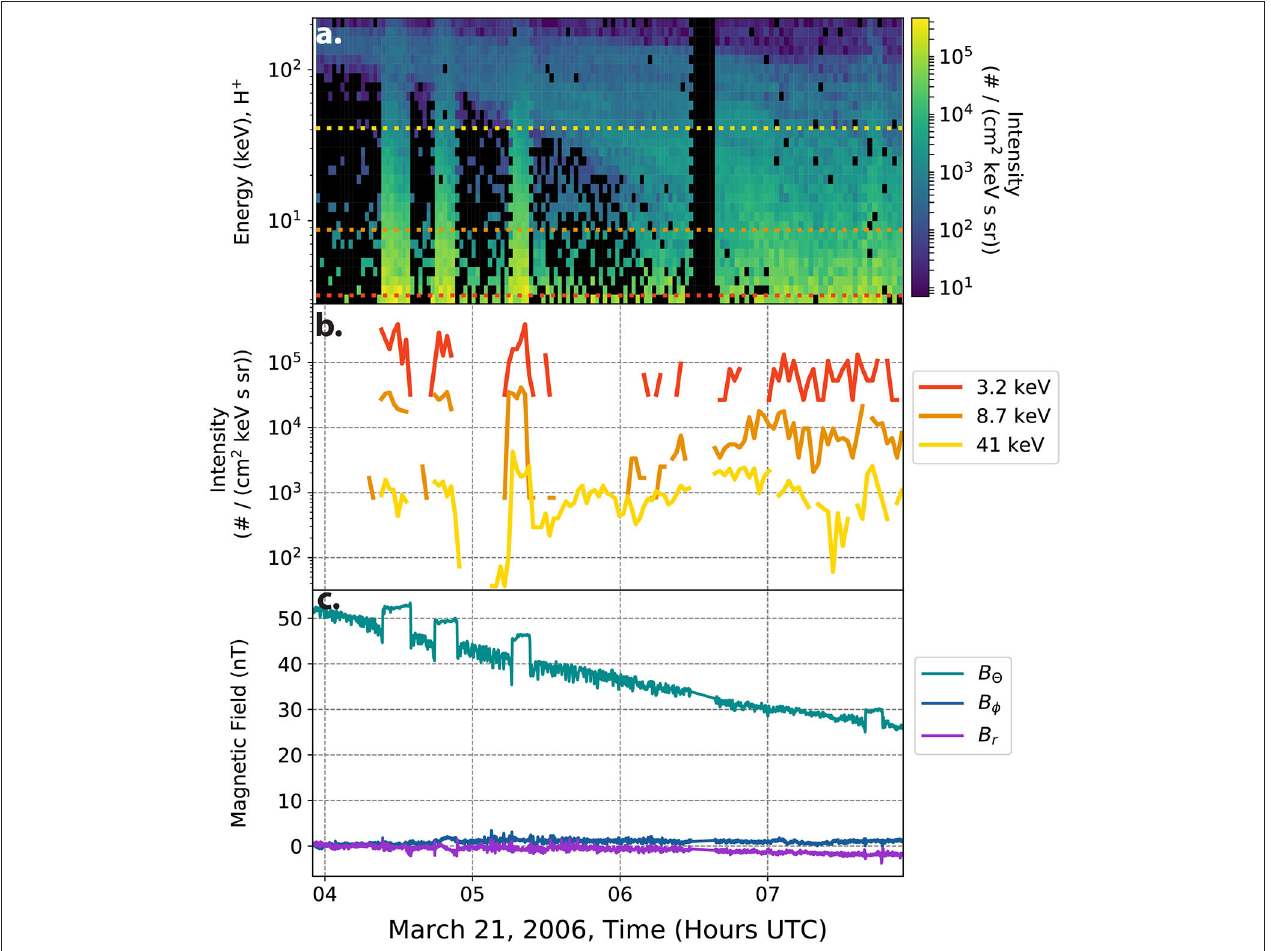
FIGURE 3 | Series of interchange injections characterized by high-energy ions. (a) Details an energy time spectrogram of the intensity from the Cassini CHEMS sensor. The color black denotes flux either below the colorbar limit or missing data. The three lines are placed at the energy channels for the plot in (b) . (b) Shows the same CHEMS data, but split out into three characteristic energies over the entire CHEMS range. (c) Shows the magnetic field data in KRTP (Kronocentric body-fixed, J2000 spherical